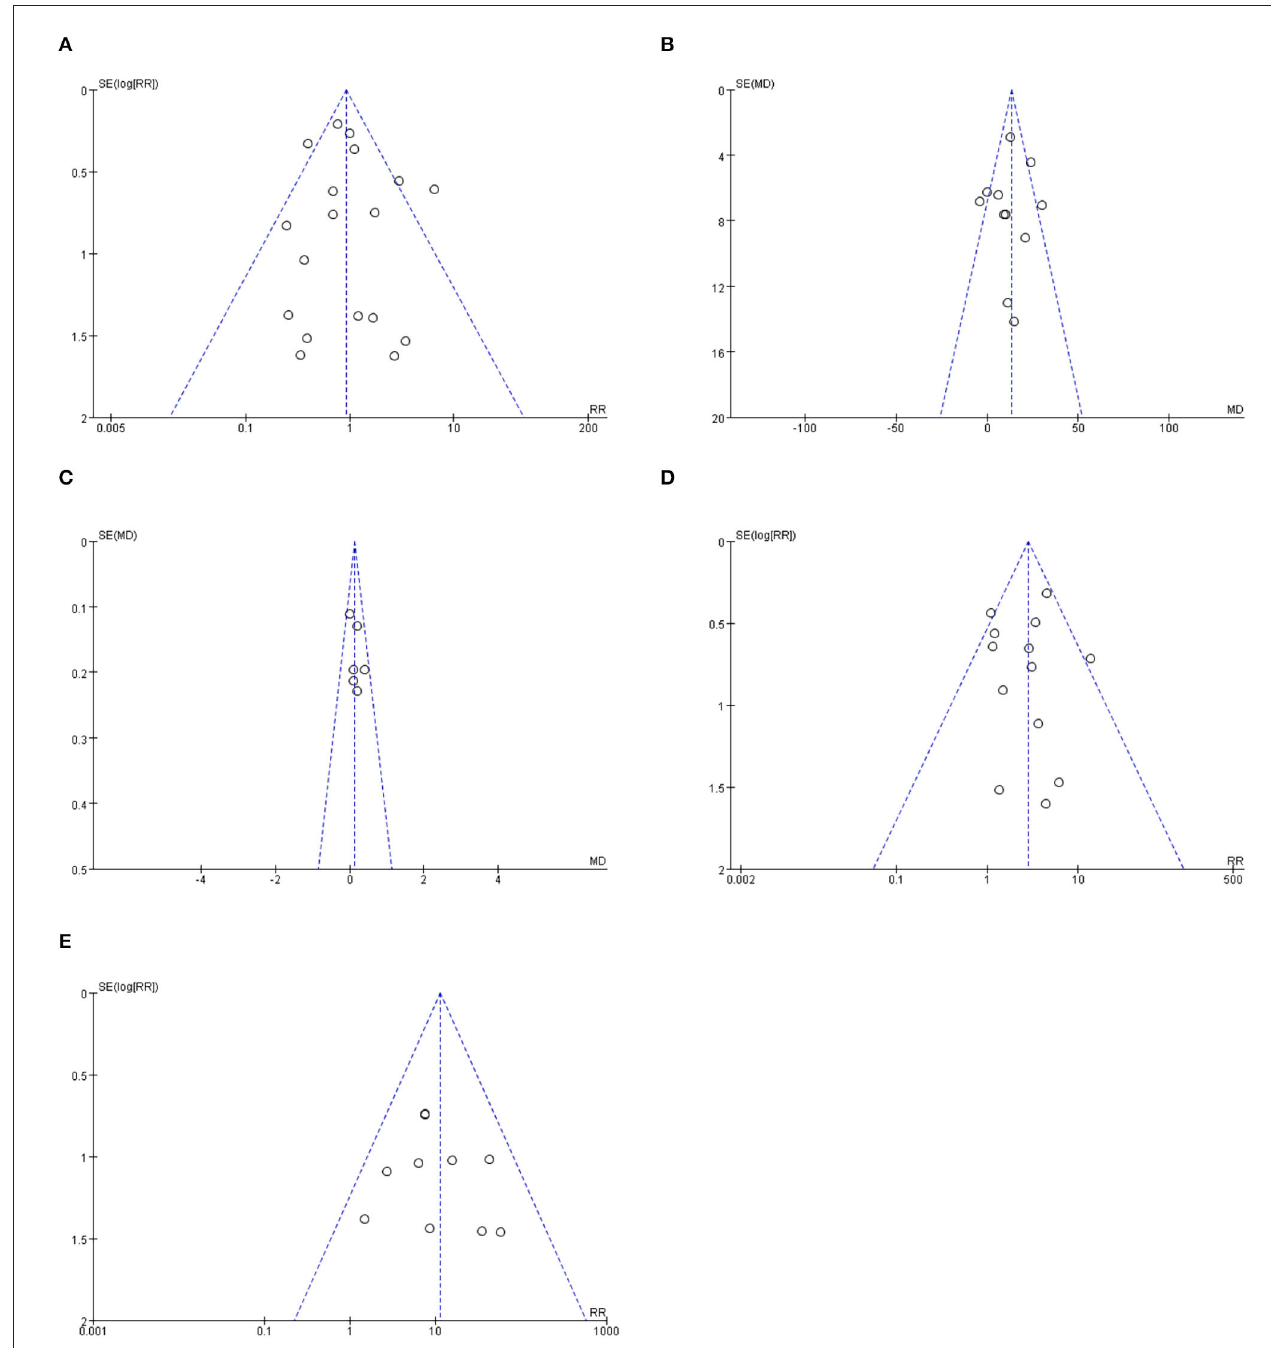
FIGURE 7 | The funnel plot for the included studies of differential outcome indicators. (A) shows the funnel plot for publication bias of all-cause mortality related studies. (B) shows the funnel plot for publication bias of Reduction in left ventricular outflow tract pressure gradient. (C) shows the funnel plot for publication bias of improvement on cardiac function. (D) shows the funnel plot for publication bias of risk of permanent pacemaker implantation. (E) shows the funnel plot for publication bias of risk of